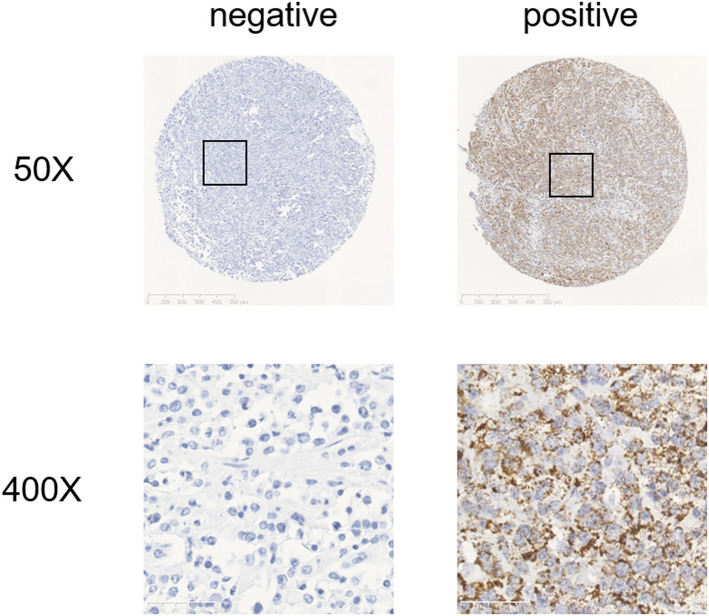
Representative RNA in situ hybridization images of samples negative and positive for CCND2 mRNA expression.